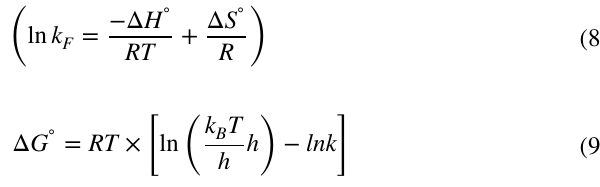
Table 3 Thermodynamic Parameters for oxidation of LFR and LA by AS-Fenton